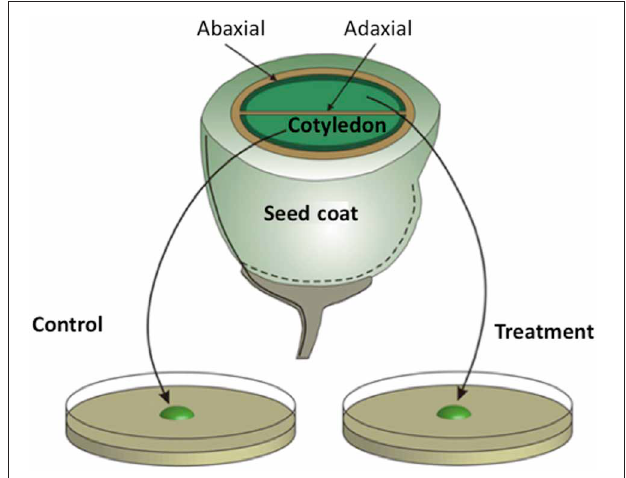
FIGURE 3 | Schematic of a transfer cell inductive system using Vicia faba cotyledons. An equatorial view of a V. faba seed sliced transversely in half. A maternal seed coat encloses two large cotyledons. At the maternal/filial interface, thin-walled parenchyma cells of the seed coat and abaxial epidermal cells of the cotyledons (solid dark green lines) trans -differentiate to a transfer cell morphology. In contrast, adaxial epidermal cells of the cotyledons do not trans -differentiate to a transfer cell morphology. Upon surgical removal of cotyledons from their enclosing seed coats and transfer to a MS medium, cotyledon adaxial epidermal cells undergo a synchronous trans -differentiation to transfer cells that are structurally and functionally identical to their abaxial counterparts. Sister cotyledons of each seed are randomly allocated to MS medium alone or a MS medium carrying a pharmacological agent that interferes with developmental signals or wall building